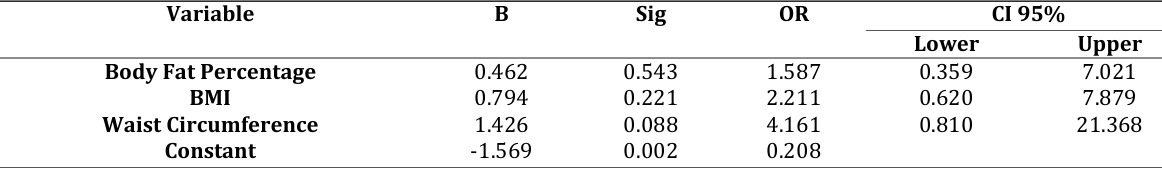
Table 3. The result of First Step Multiple Regression Logistic Analysis